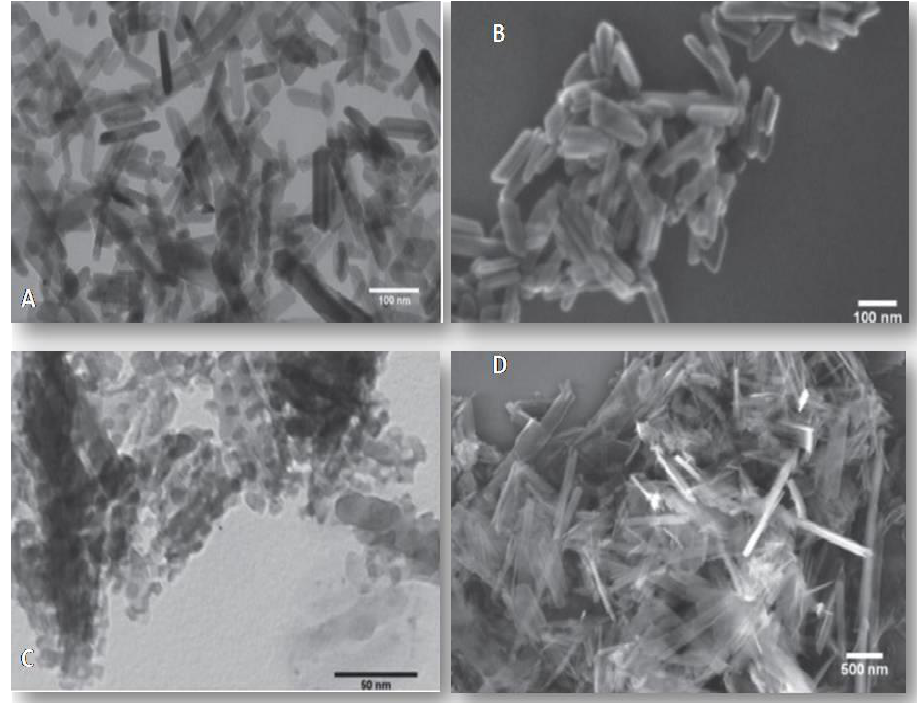
Figure 3. Electron microscopy images (transmission electron microscopy—TEM, and scanning electron microscopy—SEM) of hydroxyapatite nanoparticles synthesized by hydrothermal processes by Arantes et al. [7]: ( A ) HA nanoparticles obtained at 100 ◦ C, over 24 h, with the precursor concentrations of 0.03 mol/L − 1 (TEM, scale bar value 100 nm); ( B ) HA nanoparticles obtained at 140 ◦ C, over 48 h, with the precursor concentrations of 0.03 mol/L − 1 (SEM, scale bar value 100 nm); ( C ) HA nanoparticles obtained at 100 ◦ C, over 24 h, with the precursor concentrations of 0.1 mol/L − 1 (TEM, scale bar value 50 nm) ( D ) HA nanoparticles obtained at 140 ◦ C, over 48 h, with the precursor concentrations of 0.1 mol/L − 1 (SEM, scale bar value 500 nm). Adapted from [7] under the terms